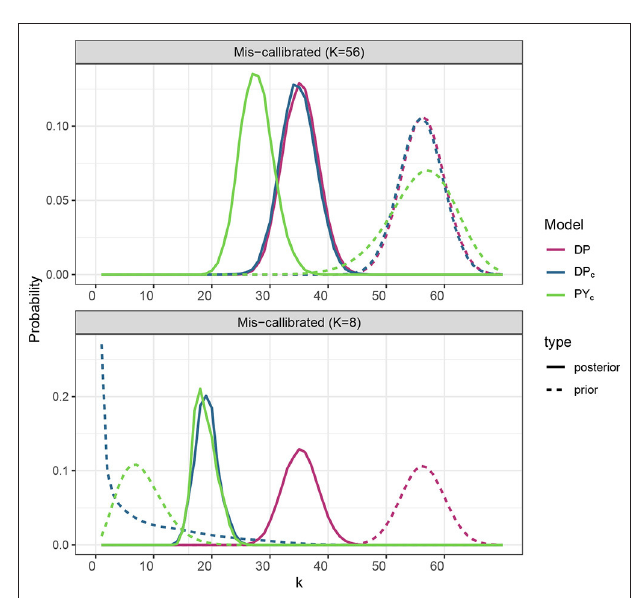
FIGURE 3 | Prior and posterior distribution of the number of clusters for the models DP c , PY c corresponding to the different prior specification of the number of clusters, where prior expected number of clusters E [ K S ] take values in { 8,56 }